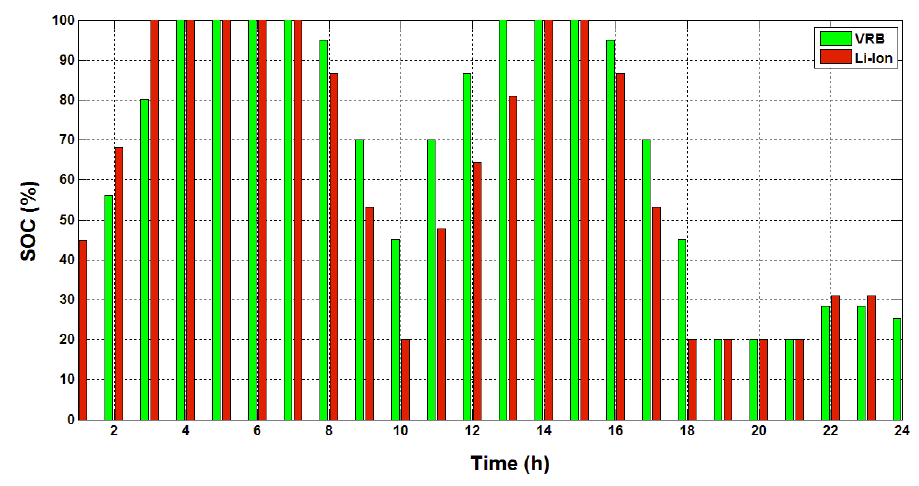
Figure 8. SOCs of the ESS units obtained using ACO.